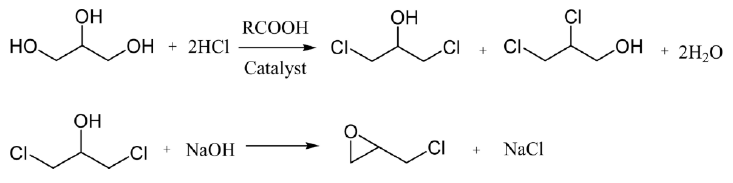
Figure 11. The reaction of glycerol to epichlorohydrin (GTE process).